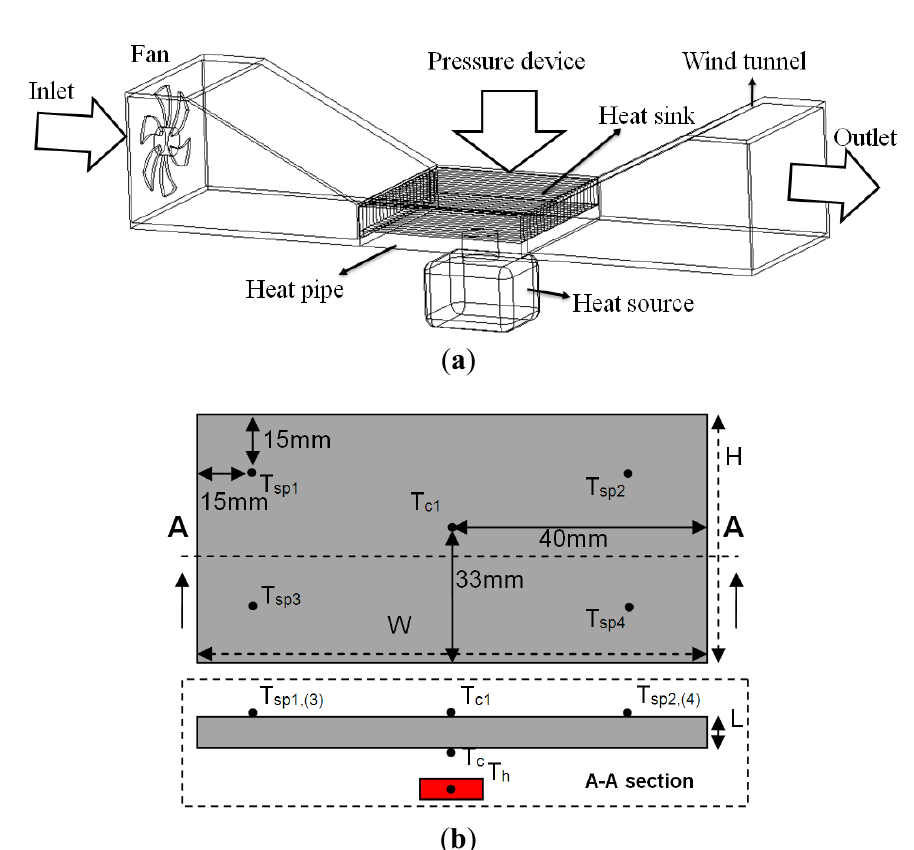
Figure 2. ( a ) NHST heat pipe measurement device; ( b ) distribution of the measurement